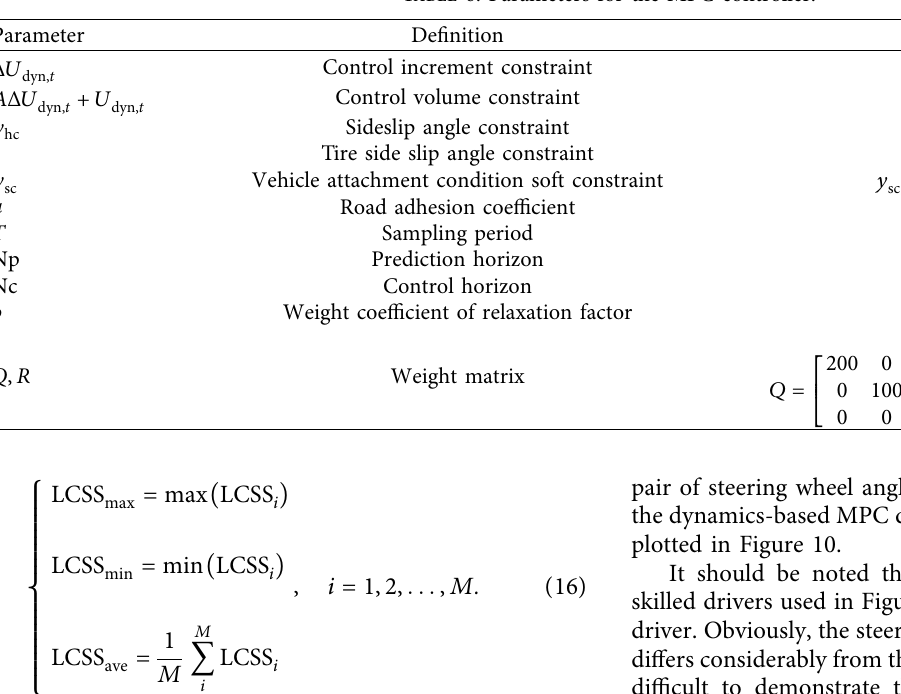
Table 6: Parameters for the MPC